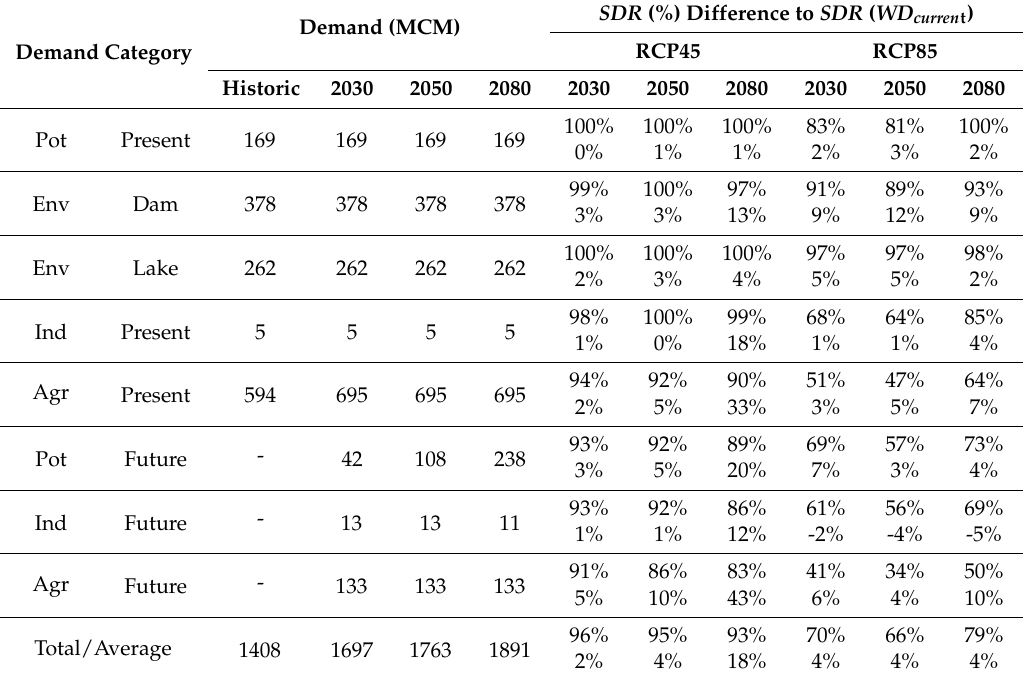
Table 7. Similar to Table 6, but for the WD recom water demand scenario. Included are the percentile difference of the SDR s with those of the WD current